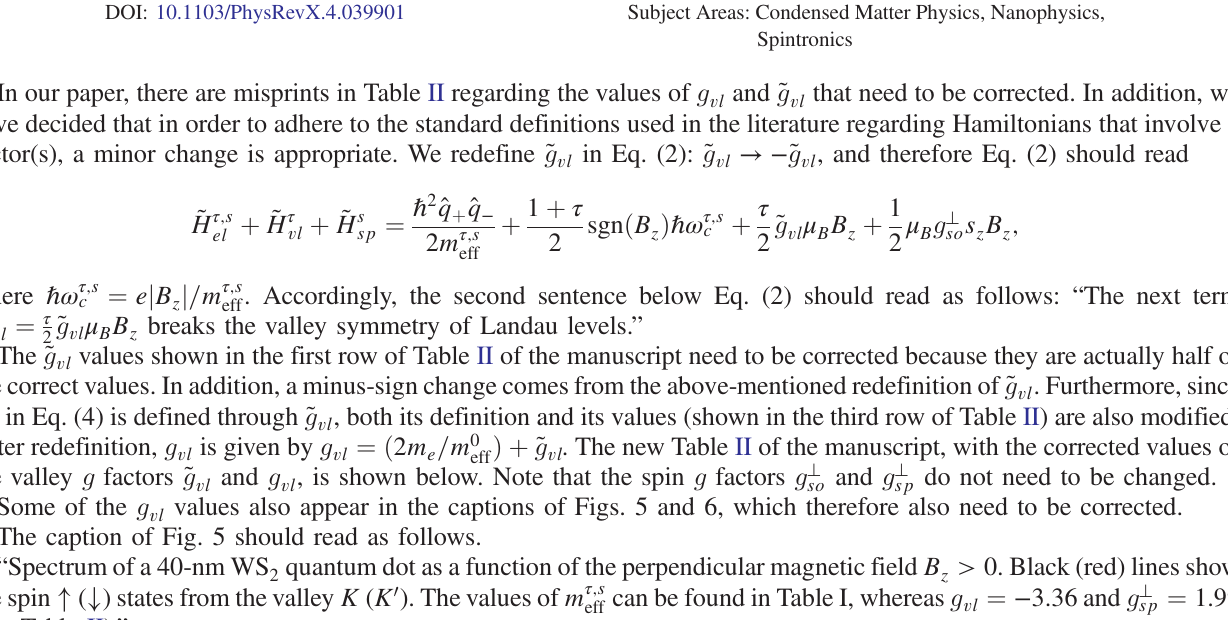
TABLE II. Valley ( ~ g , g ) and spin ( g ⊥ , g ⊥ ) g factors for different transition metal dichalcogenides. so sp vl vl MoS 2 WS 2 MoSe 2 WSe 2 ~ g − 7 . 14 − 9 . 92 − 6 . 06 − 8 . 68 vl j 0.21 0.84 0.29 0.87 j g ⊥ so − 2 . 83 − 3 . 36 − 2 . 71 − 2 . 85 g vl g ⊥ 1.98 1.99 2.07 sp